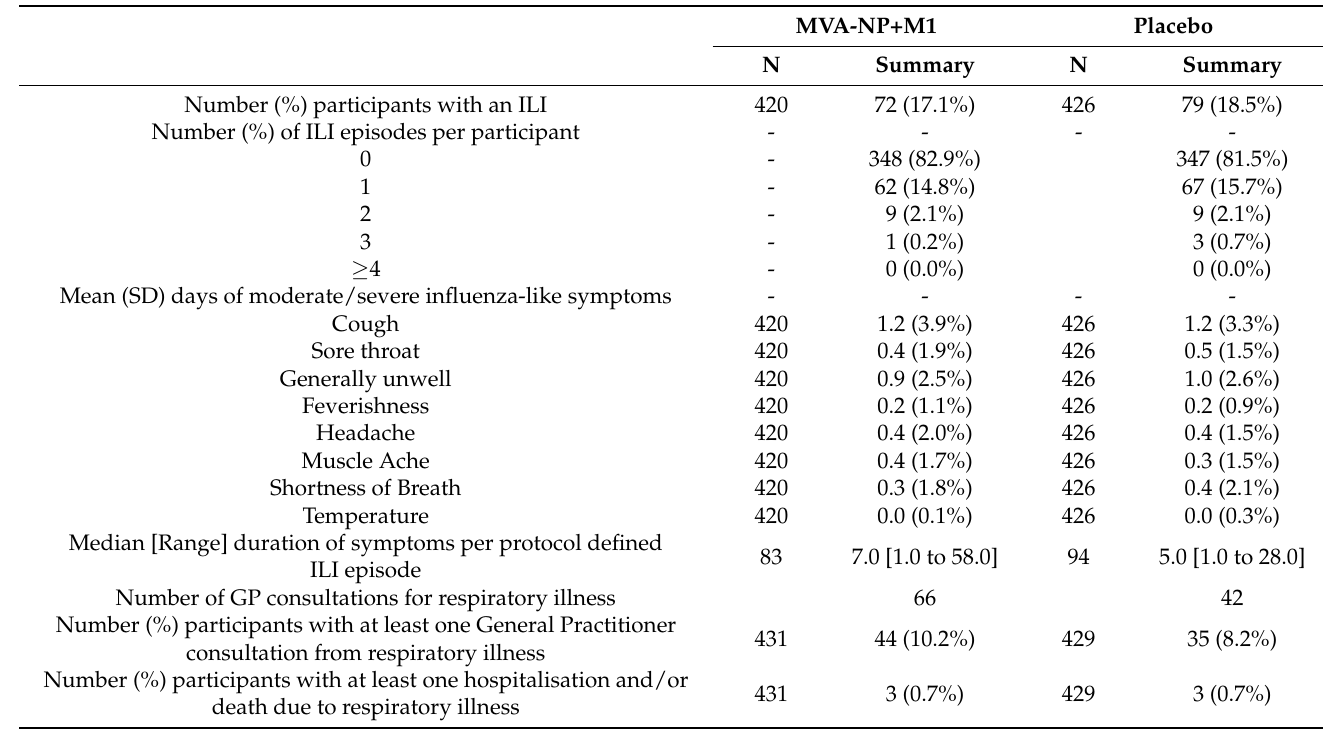
Table 3. Summary of Secondary Efficacy Endpoints (ITT